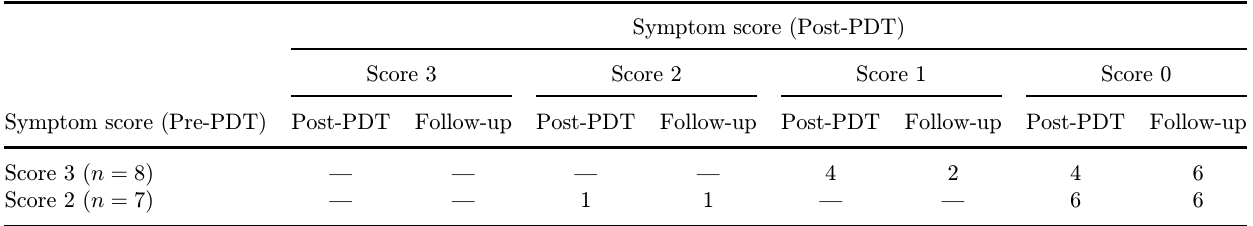
Table 3. Symptom score for OLP lesions at the pre-, post-treated and follow-up